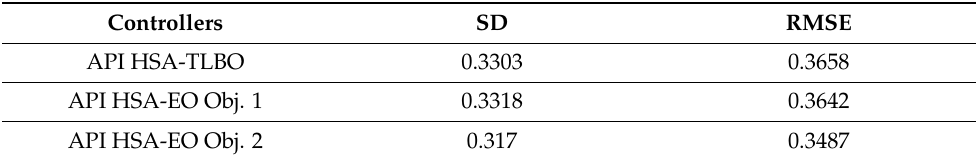
Table 9. Statistical analysis of the active power—normal fourth case.